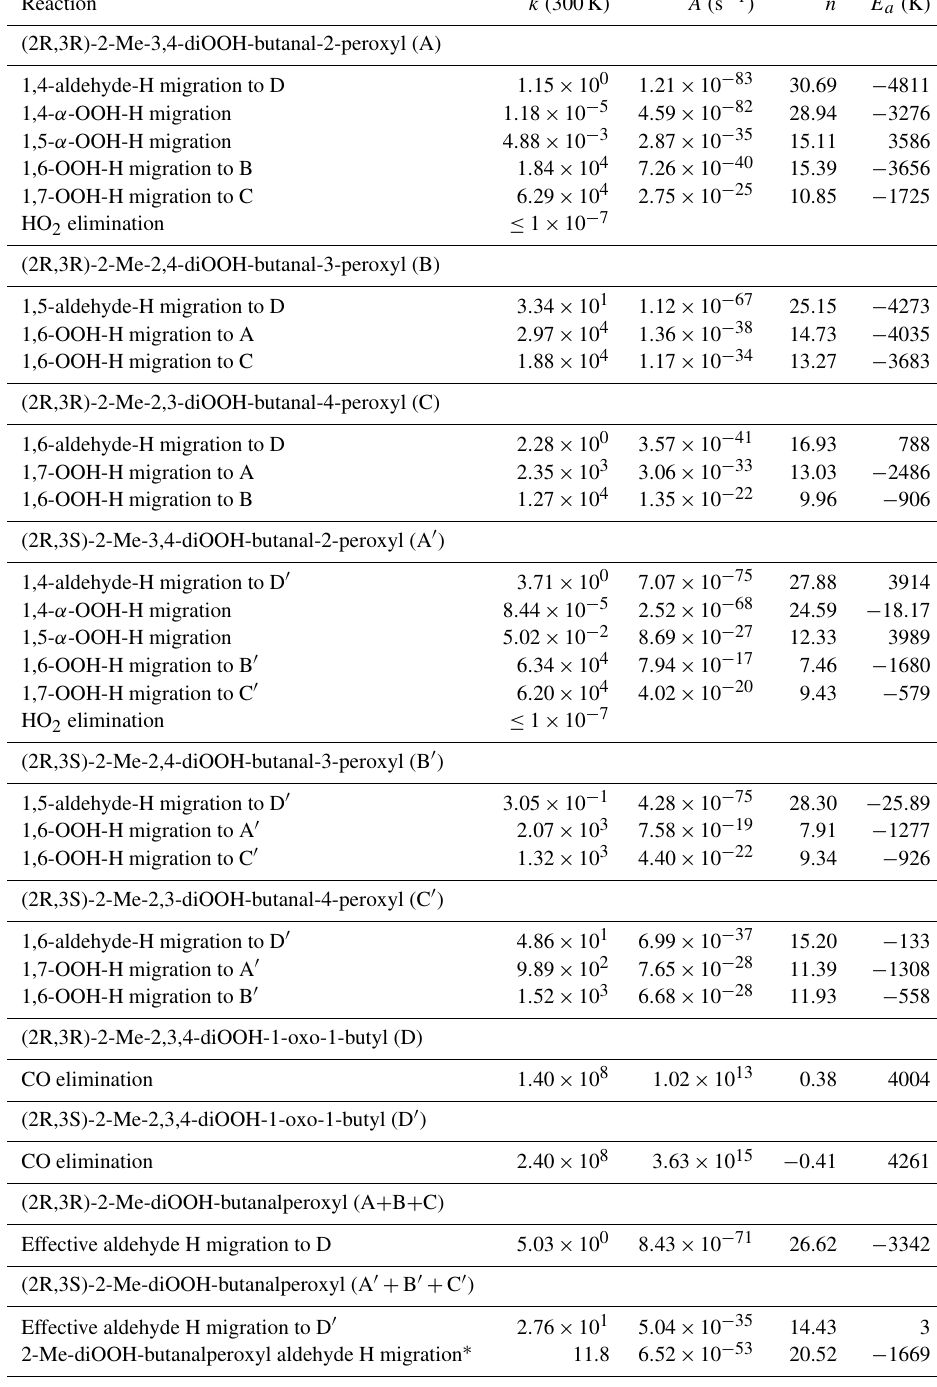
∗ Average of the data for (2R,3R) and (2R,3S)